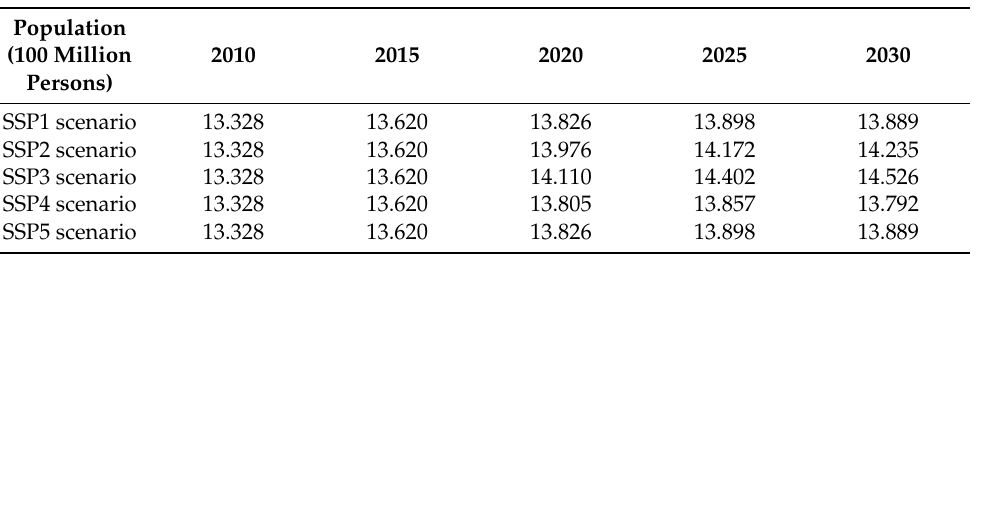
Table A1. The simulation results of the Chinese population SSPs